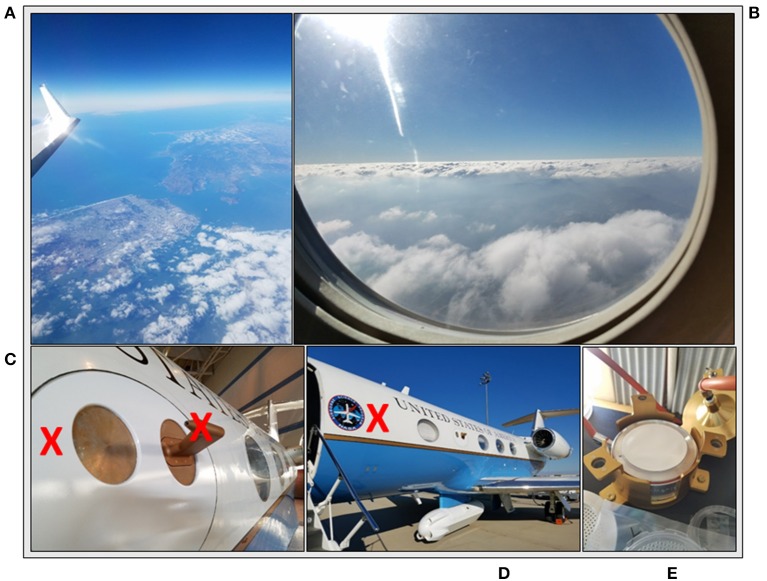
Experimental design overview. (A) Cruise samples at ~12 km; (B) Ascent/Descent samples ranging from 0.3 to 12 km; (C) Ground hardware samples (probe and window plate, red X indicating area swabbed); (D) Ground samples (side of aircraft, red X indicating area swabbed); and (E) Negative control sample where blank filter was loaded into cascade sampler.